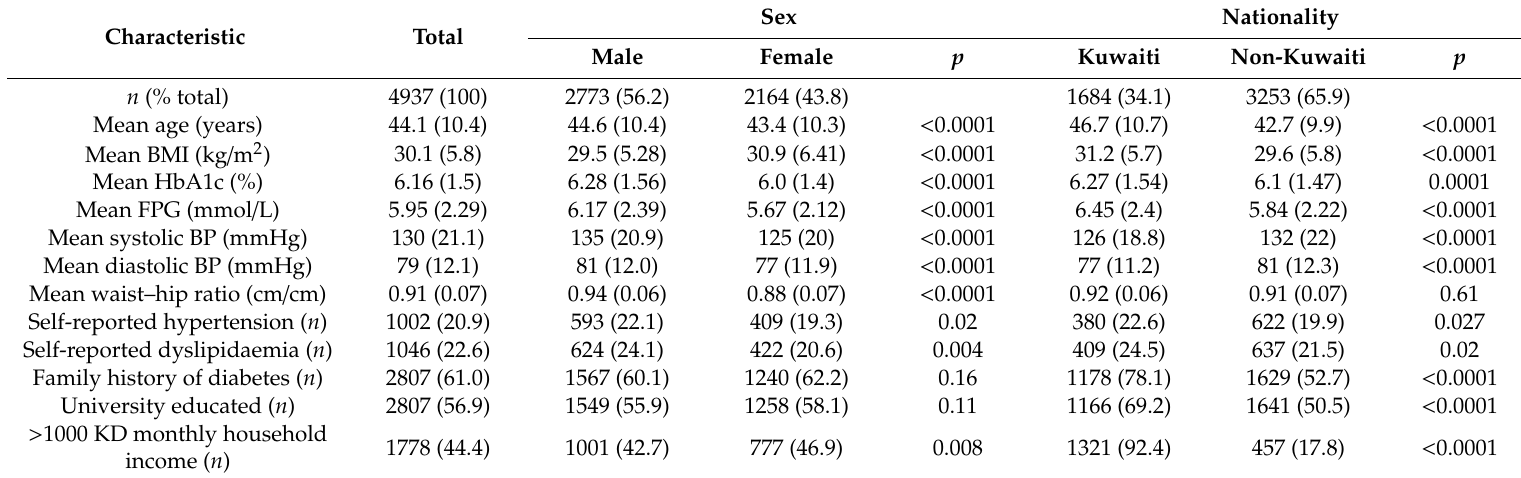
Table 1. Participants’ demographic and clinical characteristics according to sex and nationality a . KDEP Survey, adults in Kuwait aged 20 years or more.